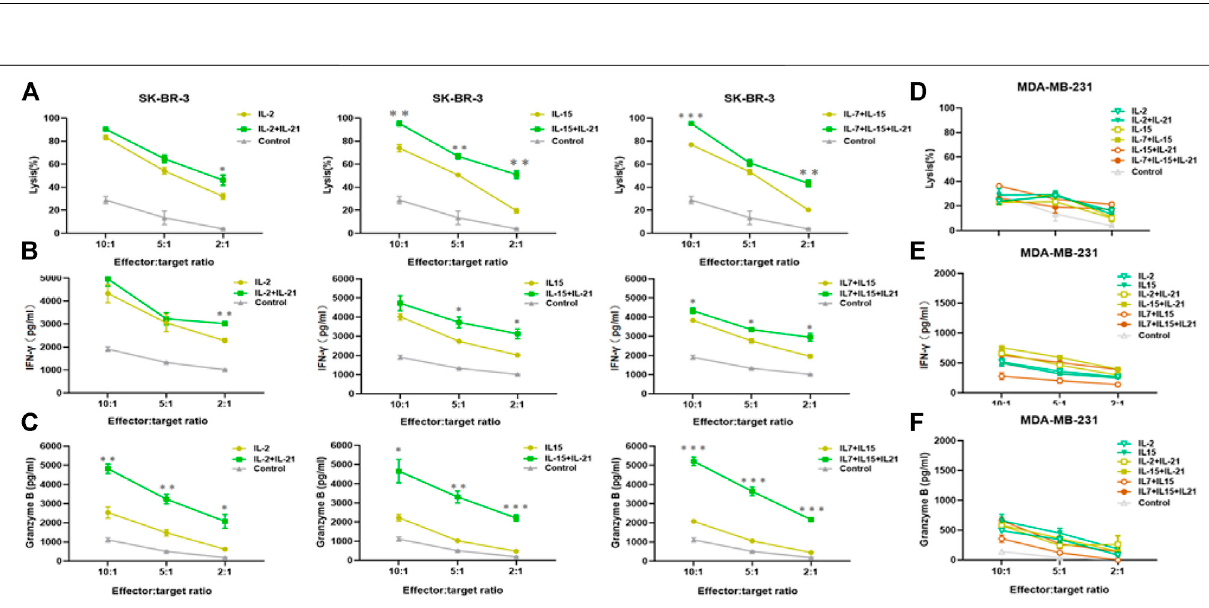
Frontiers in Molecular Biosciences |